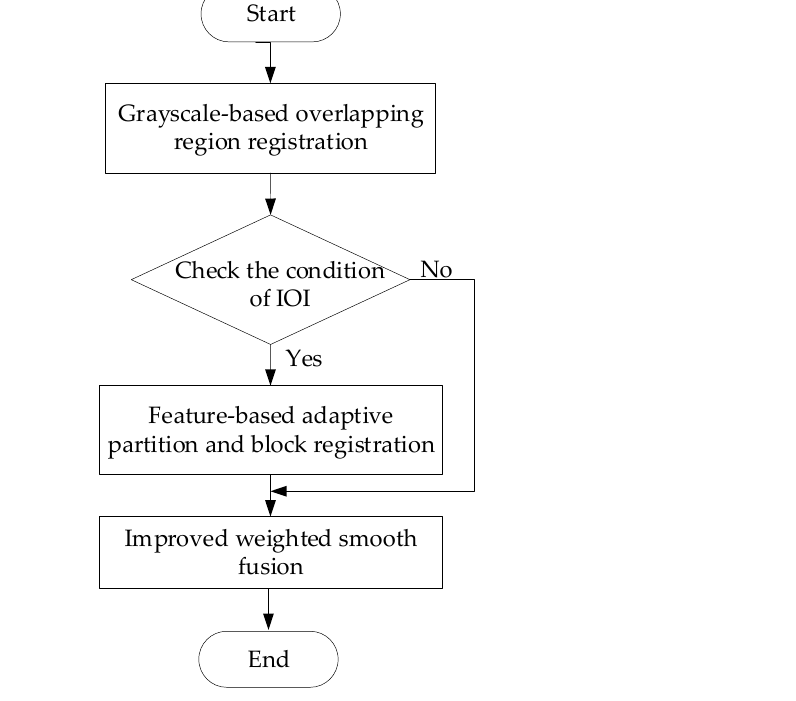
Figure 3. Flow chart of the adaptive multi-view image mosaic (AMIM) method.